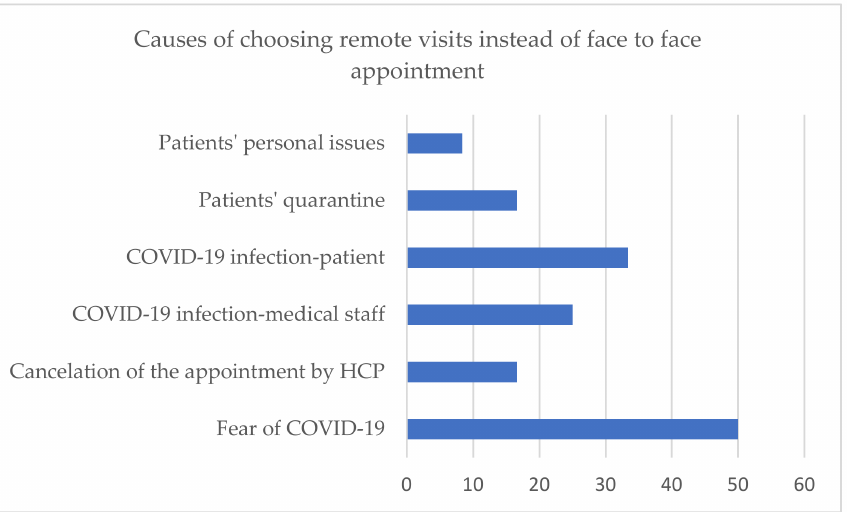
Figure 3. Causes of choosing telemedicine instead of “face-to-face” appointment (HCP—health care providers).